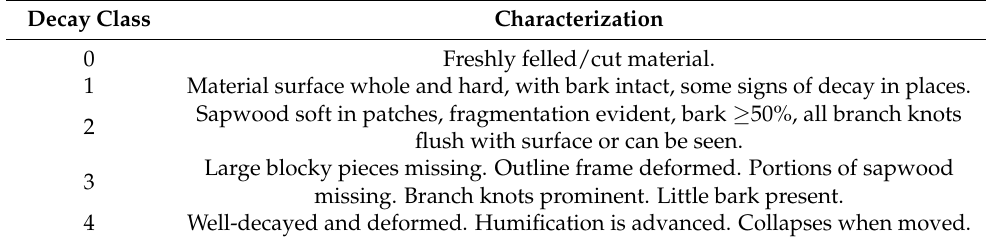
Table 2. A five-category decay class system (described in Tobin et al. [11] and Olajuyigbe et al. [30]) was used to assess the degree of decomposition of windrowed woody debris (logs, branches and